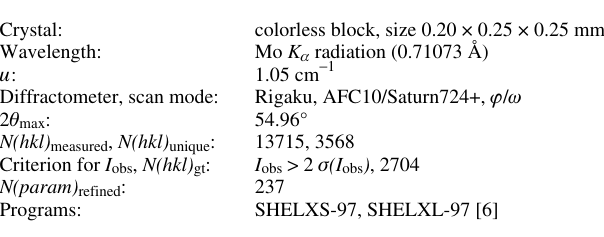
Table 1. Data collection and handling.